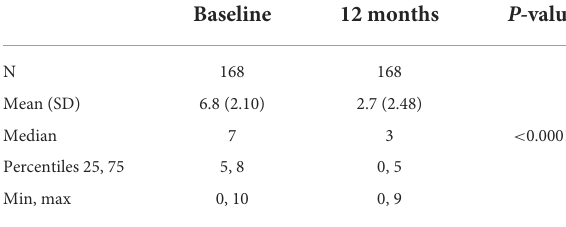
TABLE 8 Craving for alcohol in Group